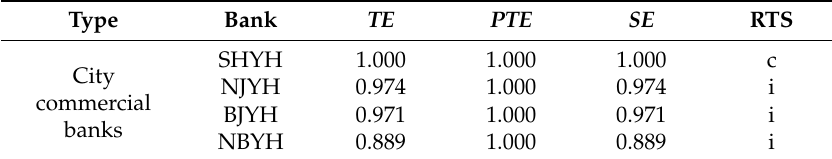
Table 7. The efficiency evaluation of the city commercial banks in